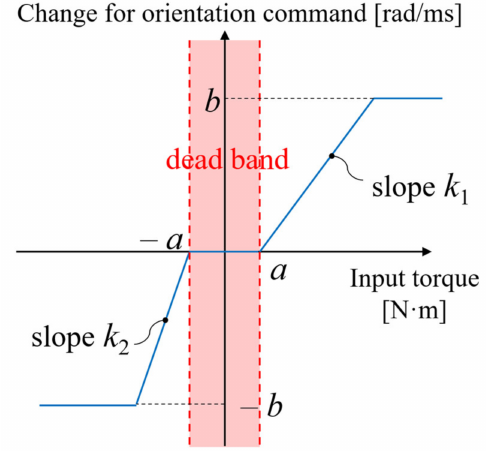
Figure 5. Relationship between input torque and robot velocity